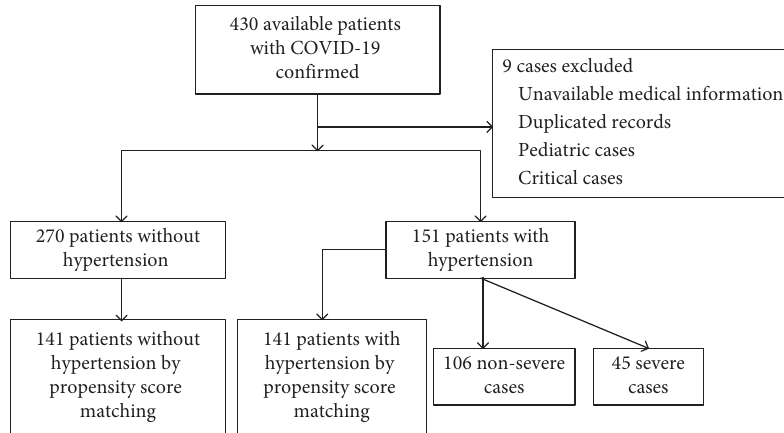
Figure 2: Flow diagram of patient screening and